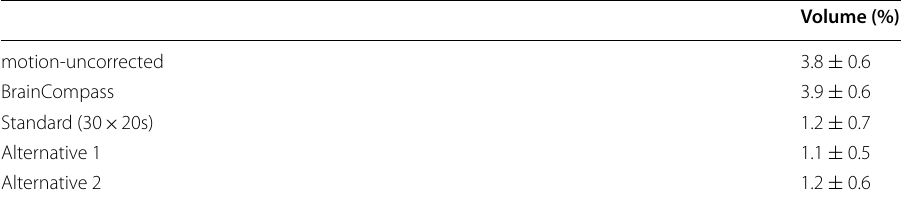
Table 3 Volume increase relative to the reference volume (with SD) for the motion pattern in Fig. 10